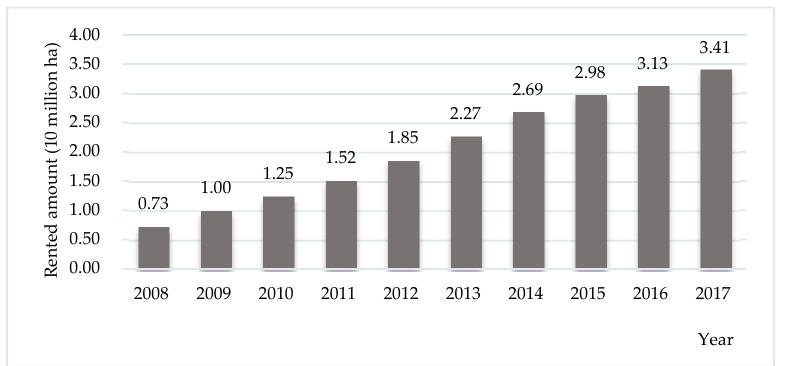
Figure 1. The variation of the total rented farmland area nationwide (2008–2017). Resource: Ministry of Agriculture and Rural Affairs of the People’s Republic of China.